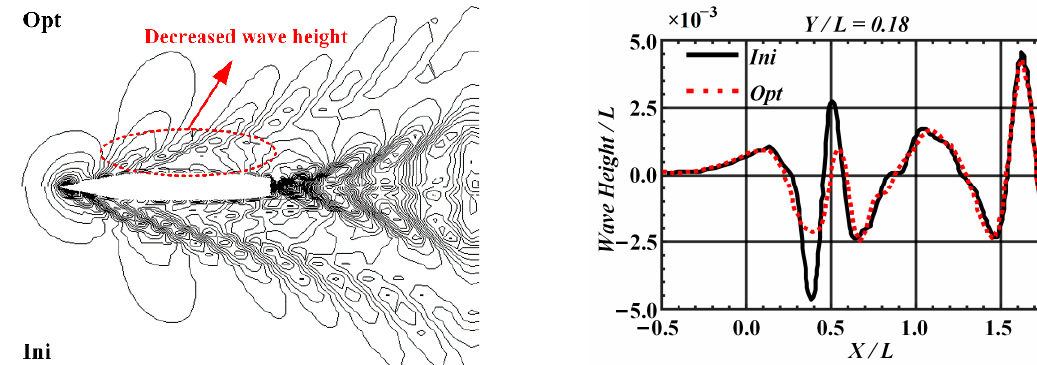
Figure 12. Comparison of the initial and the optimal.